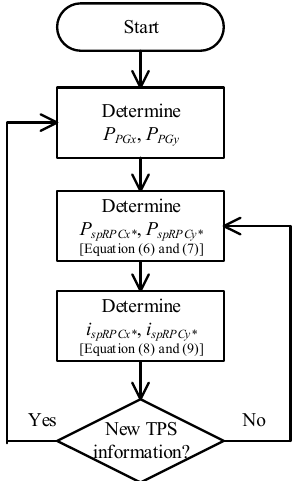
Figure 5. Simpli fi ed fl owchart of the sp-RPC control algorithm. Figure 5. Simplified flowchart of the sp-RPC control